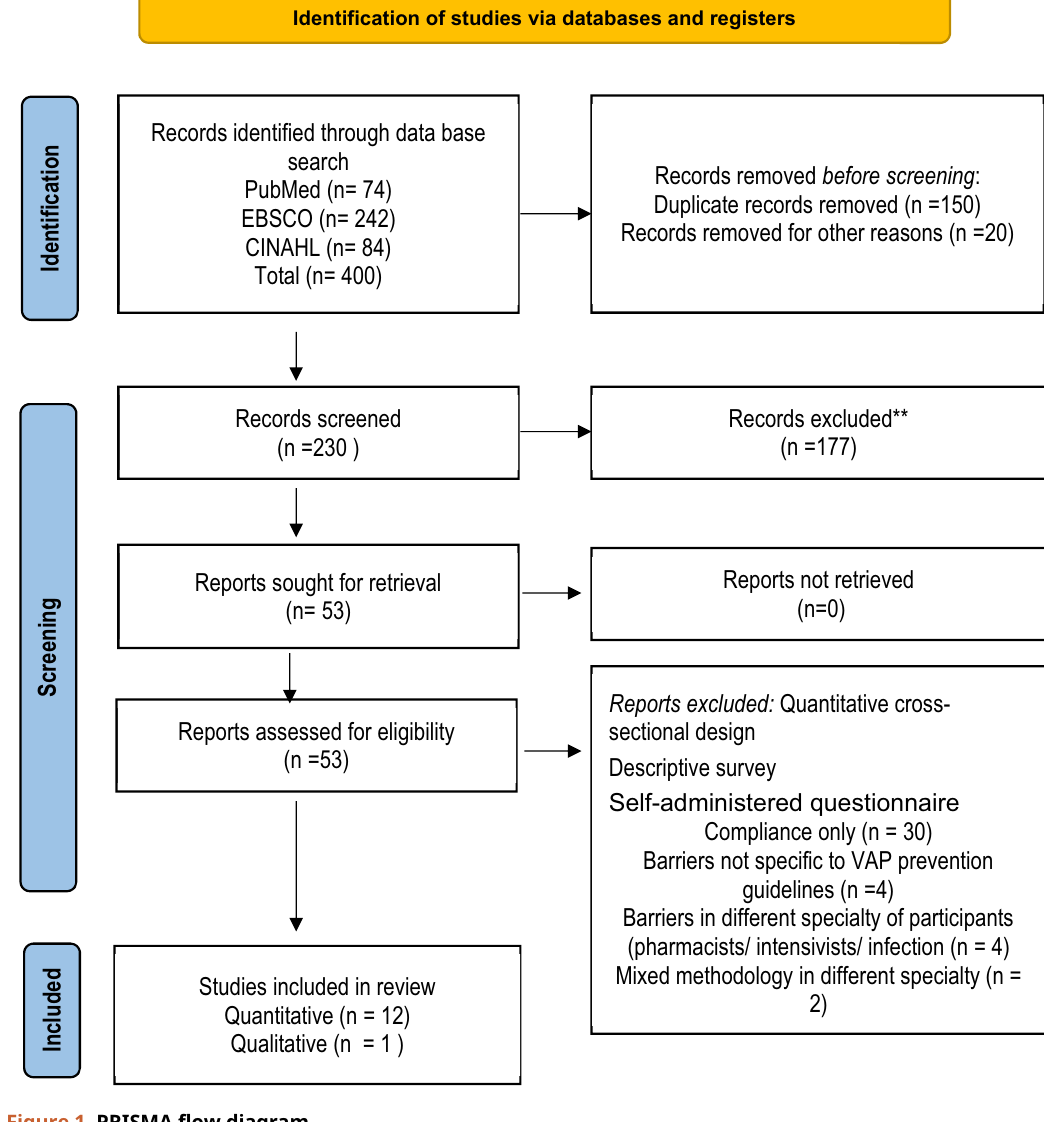
Figure 1. PRISMA flow diagram.